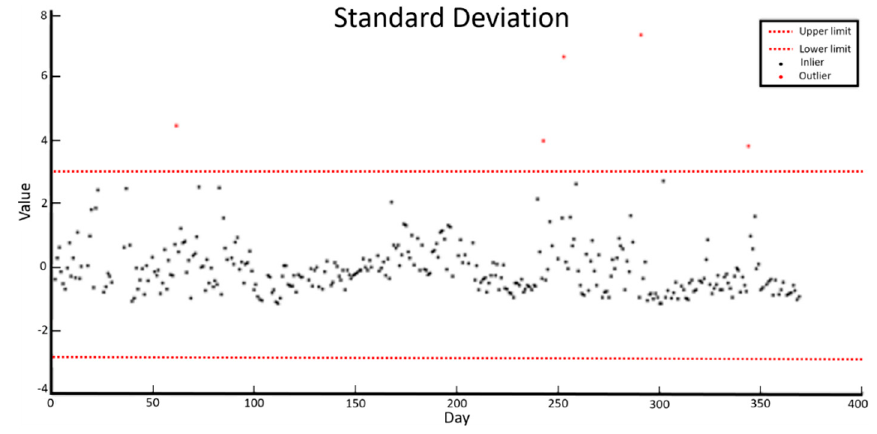
Figure 8. Z-scores distinguishing outliers (red) from the acquired inlier data (black).